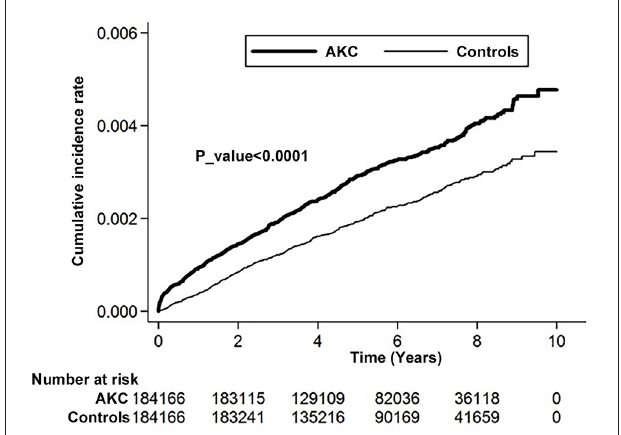
FIGURE 2 | Cumulative incidence rate of recurrent corneal erosion in patients with atopic keratoconjunctivitis and controls during the follow-up